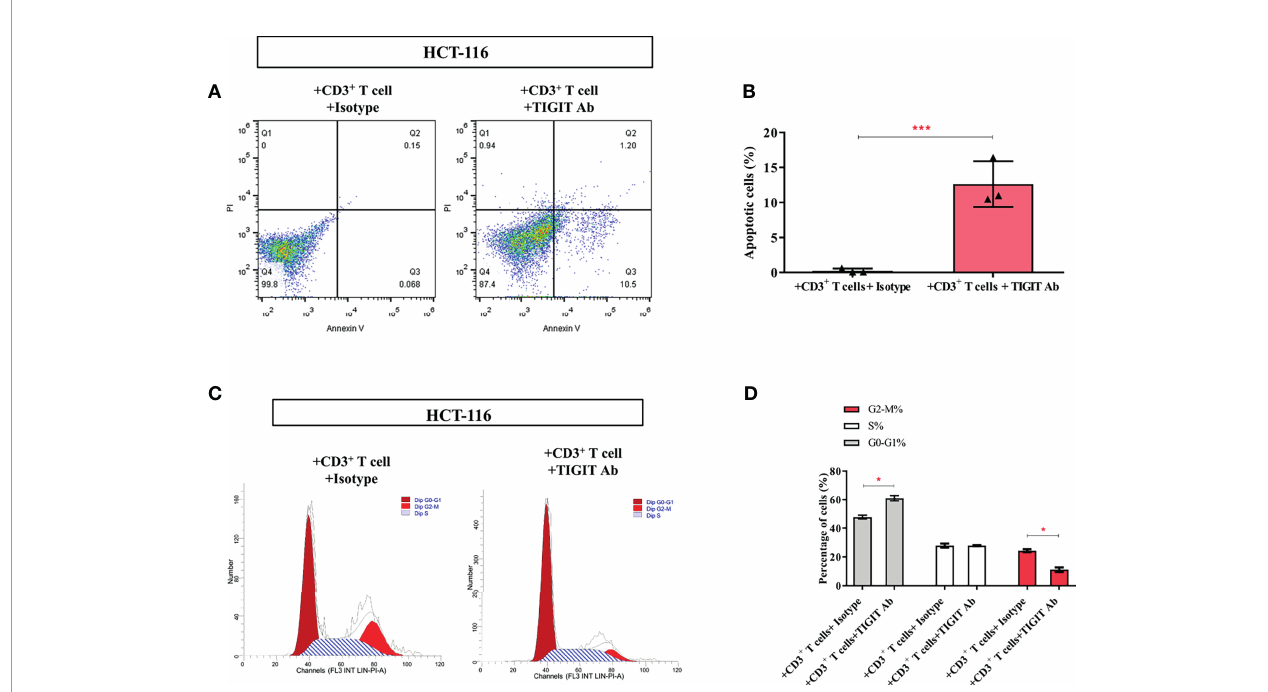
FIGURE 6 | TIGIT inhibits the proliferation of colorectal cancer cells. In the co-culture system, (A, B) Apoptosis of HCT-116 was detected cell apoptosis by Annexin V assay. (C, D) Flow cytometry was applied to determine cell-cycle distribution. * P < 0.05; *** P <